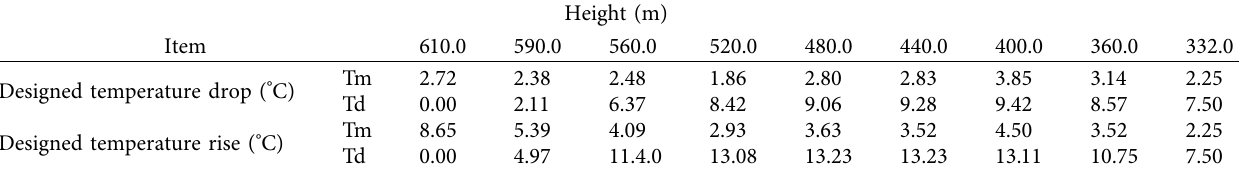
Table 3: Temperature load of normal water level ( °